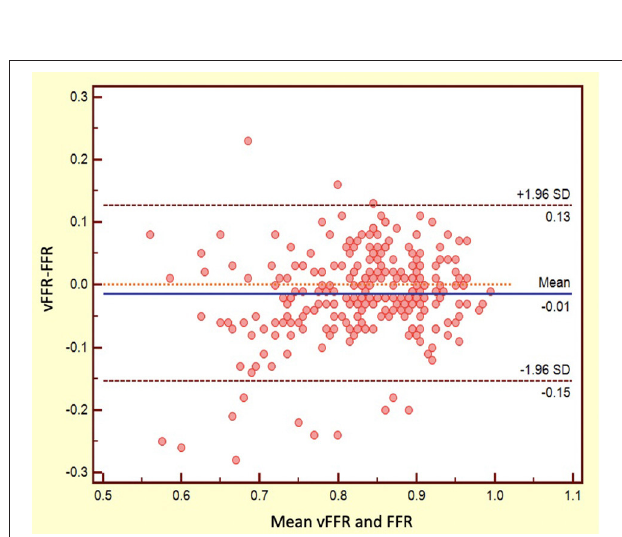
FIGURE 5 | Bland–Altman plots: vFFR vs. FFR.